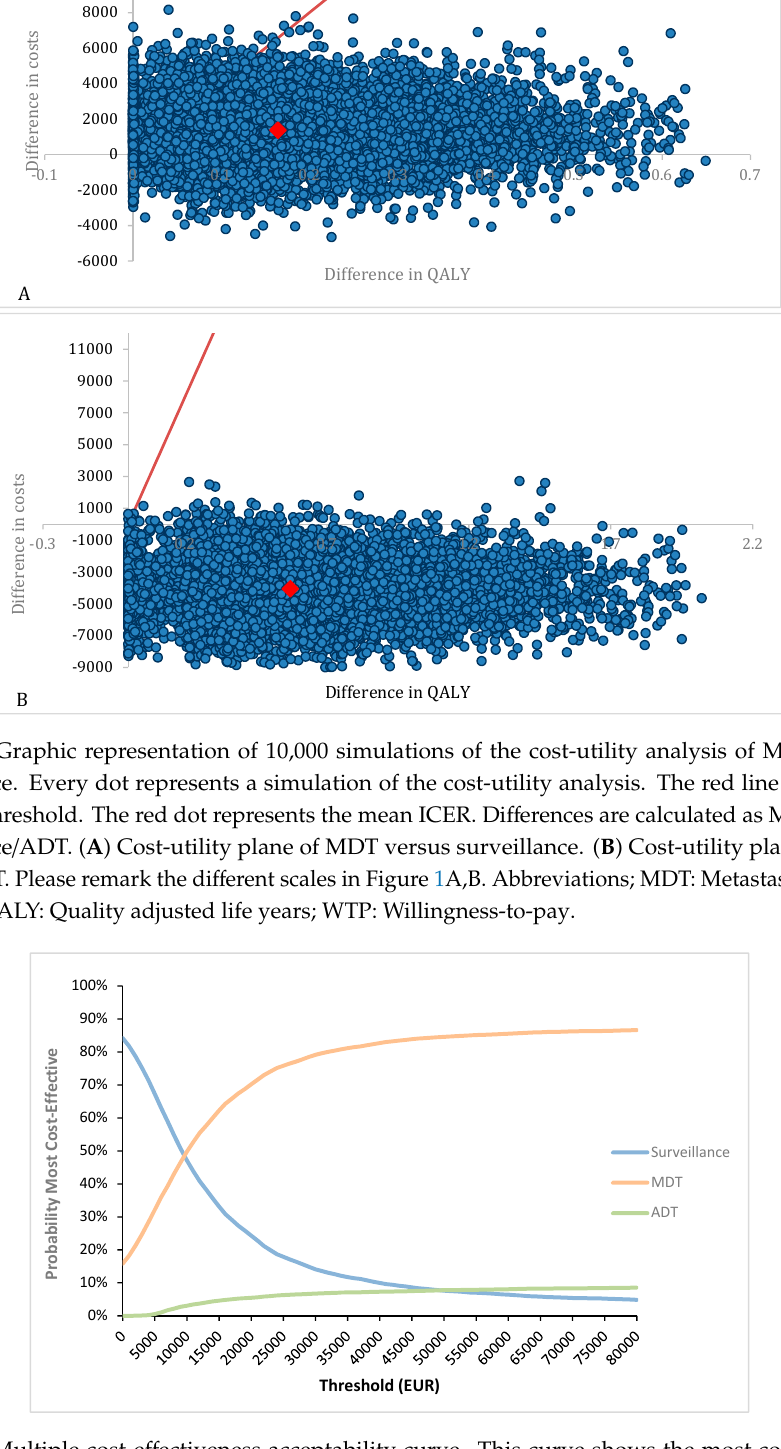
Figure 3. Multiple cost-effectiveness acceptability curve. This curve shows the most cost-effective strategy depending on the willingness-to-pay threshold. Please remark that the patients in the different groups (i.e., MDT, surveillance and ADT) entered different health states during follow-up and thus the corresponding costs and utilities of that health state were applied. ADT: Androgen-deprivation therapy; MDT: Metastasis-directed